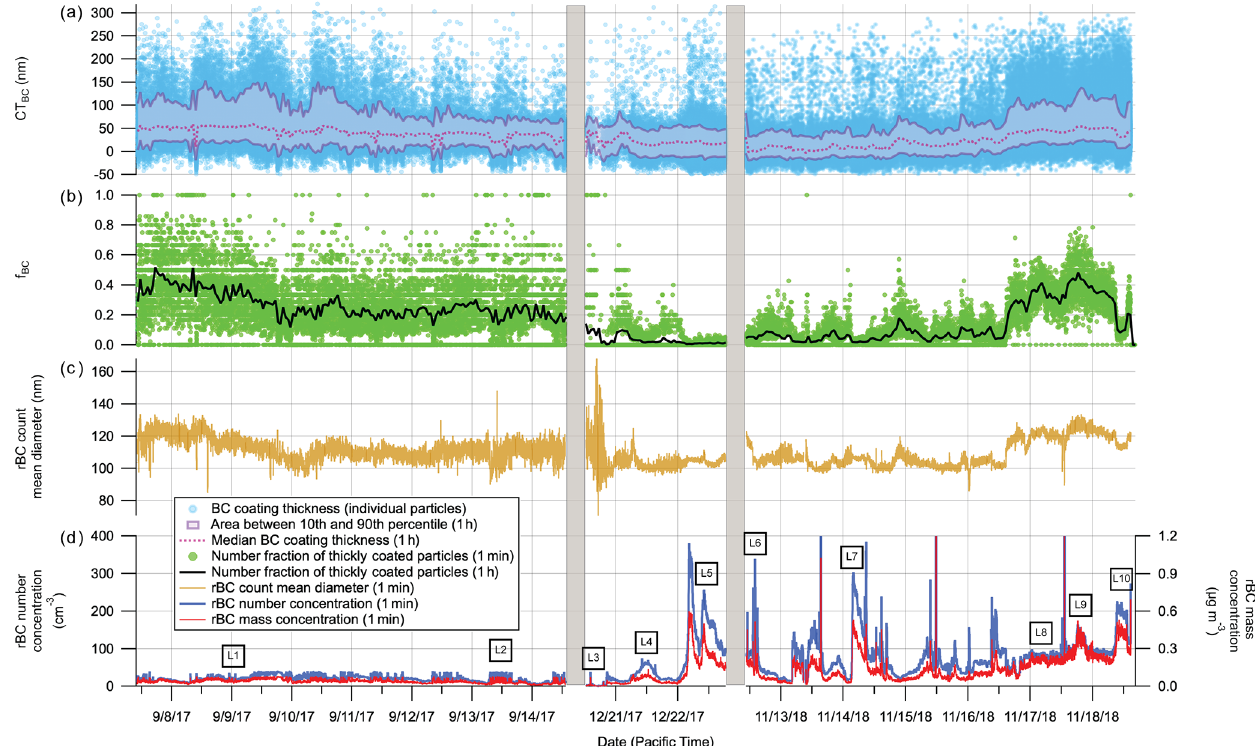
Figure 4. Time series of (a) the BC absolute coating thickness, (b) the number fraction of thickly coated rBC particles, (c) the rBC count median diameter, and (d) the rBC concentrations, for all three measurements campaigns. The boxed annotations (i.e., L1 to L10) refer to specific LEO periods, which are further described in Sect. 3.5. In panel (a) , each blue dot represents an individual particle. The hourly median is shown using the dotted pink line, and the corresponding 10th and 90th percentiles are shown in purple. In panel (b) , green dots represent 1min means, and the black curve shows hourly means. Panel (c) shows the 1min mean for the count mean diameter. Panel (d) shows the 1min means for rBC concentration. Dates on the x axis are given in the following format: